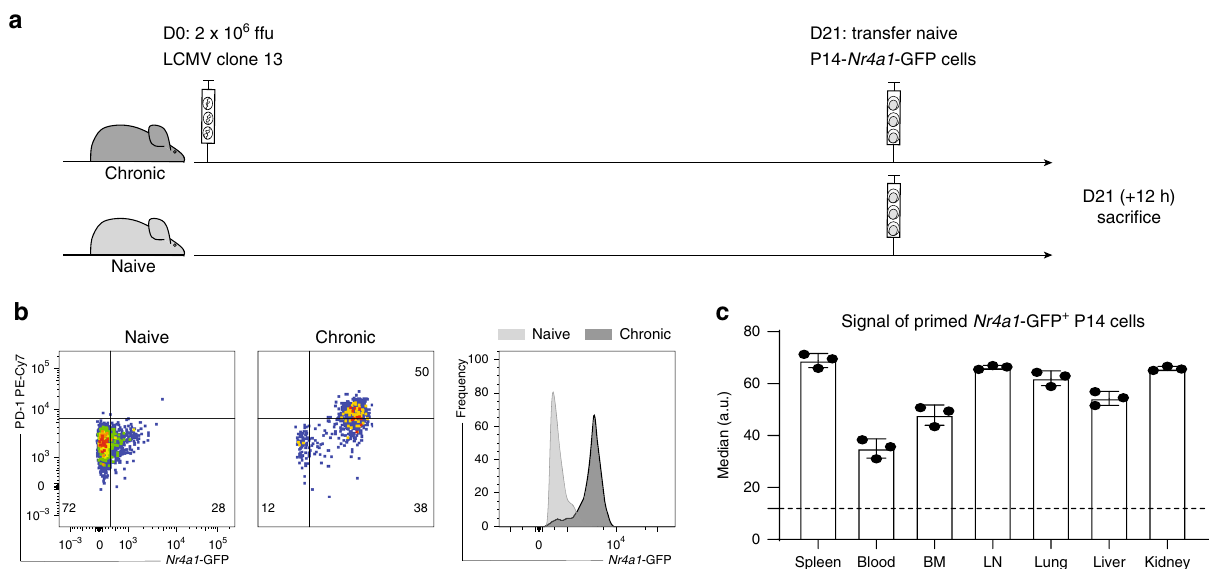
Fig. 4 Antigen is still present 3 weeks into chronic infection. a Naive P14- Nr4a1 -GFP were adoptively transferred into chronically infected or naive hosts. Nr4a1 -GFP expression in P14 cells (gated on alive single CD8 + CD45.1 + cells) isolated from various tissues was assessed 12 h later. b Representative fl ow cytometry plots and histograms (of P14 isolated from the spleen) show the difference between the two groups (chronically infected in dark gray and naive in light gray). c P14 cells isolated from all screened tissues have increased GFP levels (gated on alive single CD8 + CD45.1 + GFP + cells) compared to the signal observed in naive hosts (dotted line). Bar plots show average medians (mean ± SD). Each dot represents an individual mouse. One of three experiments is shown ( n = 3 mice). Source data are provided as a Source Data PD-1/PD-L1 axis with respect to cytotoxicity, irrespective of the